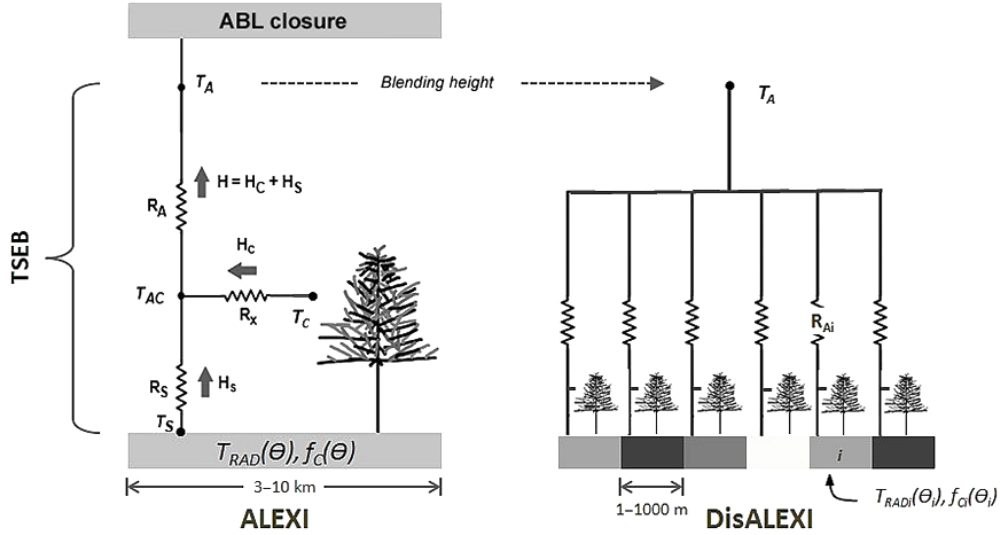
Figure 1. Schematic diagram of the ALEXI and DisALEXI modeling schemes. The left panel shows TSEB as employed to partition the income radiometric temperature ( T RAD (θ ), θ is view angle) into canopy (subscript “c”) and soil (subscript “s”) components based on vegetation coverage ( f (θ )). Sensible heat ( H ) is regulated by the aerodynamic resistance ( R a ), bulk leaf boundary layer resistance ( R x ) and soil surface boundary layer resistance ( R s ). ALEXI combines the TSEB and ABL models to estimate air temperature ( T A ) at the blending height. The right panel represents the disaggregation of ALEXI output to finer scales based on LST and f (θ ) information from Landsat and